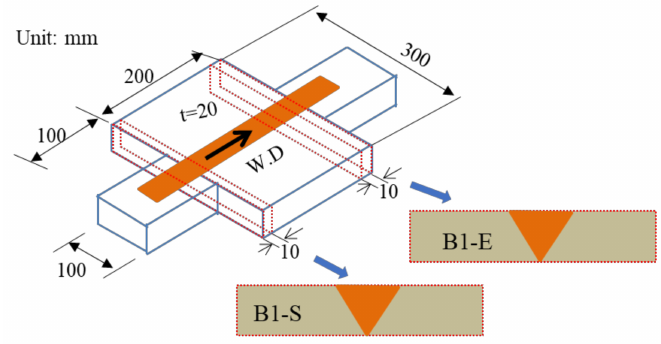
Figure 3. Location of specimen for hardness and dilution